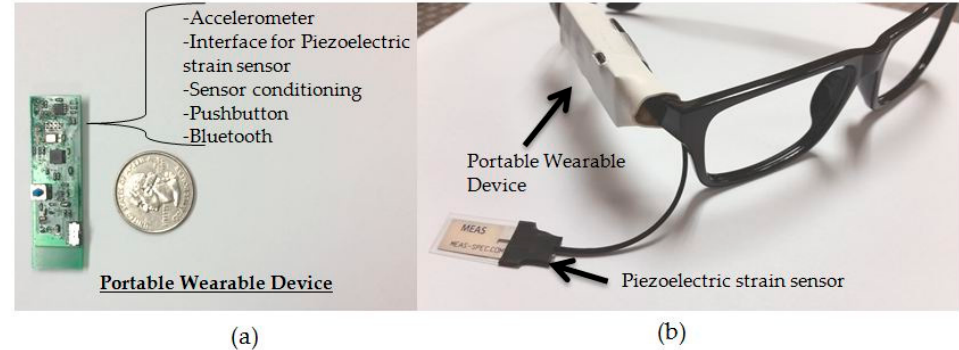
Figure 1. ( a ) Portable wearable device for monitoring of food intake and level of physical activity. The data acquisition module also has an accelerometer and Bluetooth. ( b ) Eyeglasses with a piezoelectric sensor and data acquisition device connected to the temple of glasses.